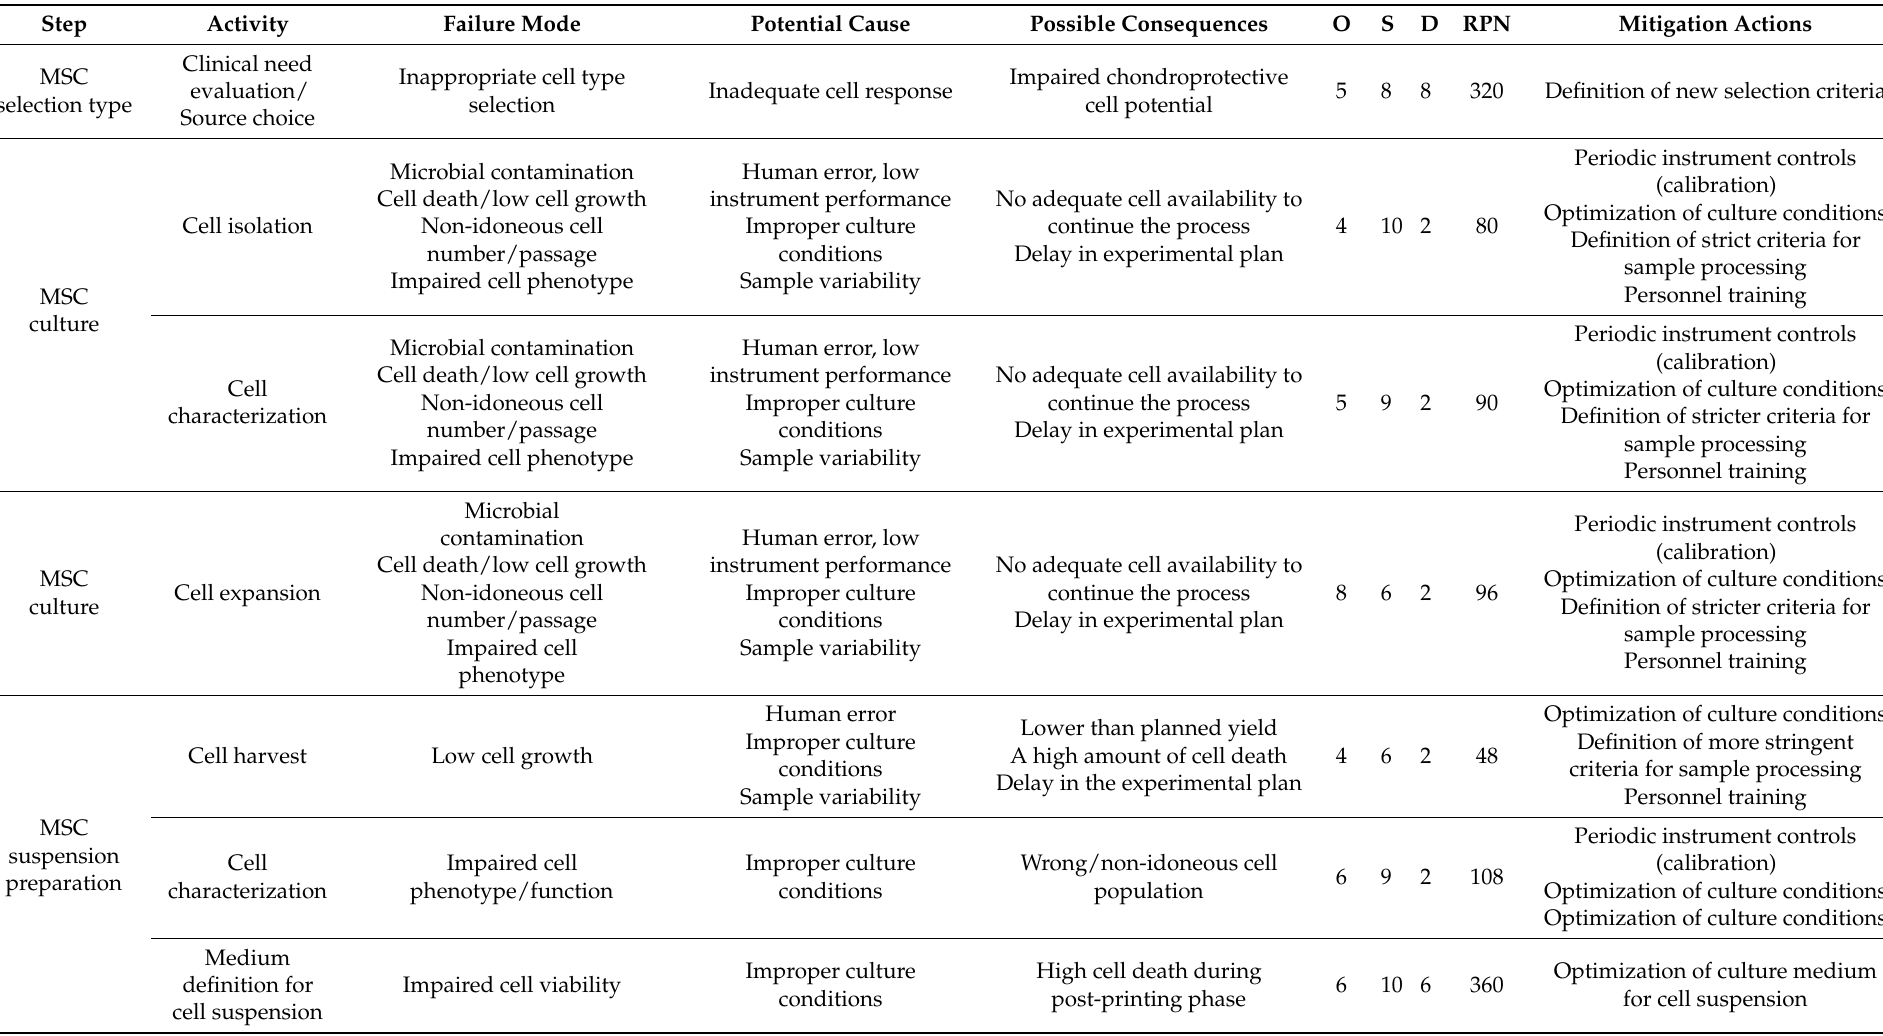
Table 5. FMEA/FMECA of the pre-bioprinting phase and cell preparation